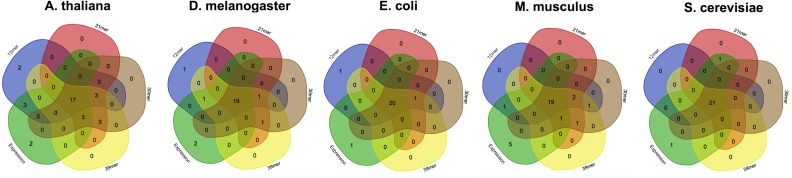
The effect of the kmer size on the corseq/CEM comparison.Venn diagrams showing the number of detected favoured codons that are shared between corseq with four different k-mer sizes and the conventional expression method. For each presented diagram, each colour region reports the number of codons that were found to be favoured following a corseq run. Overlapping regions reports the number of concordant favoured codons between four replicates and the conventional expression method for the specified species.